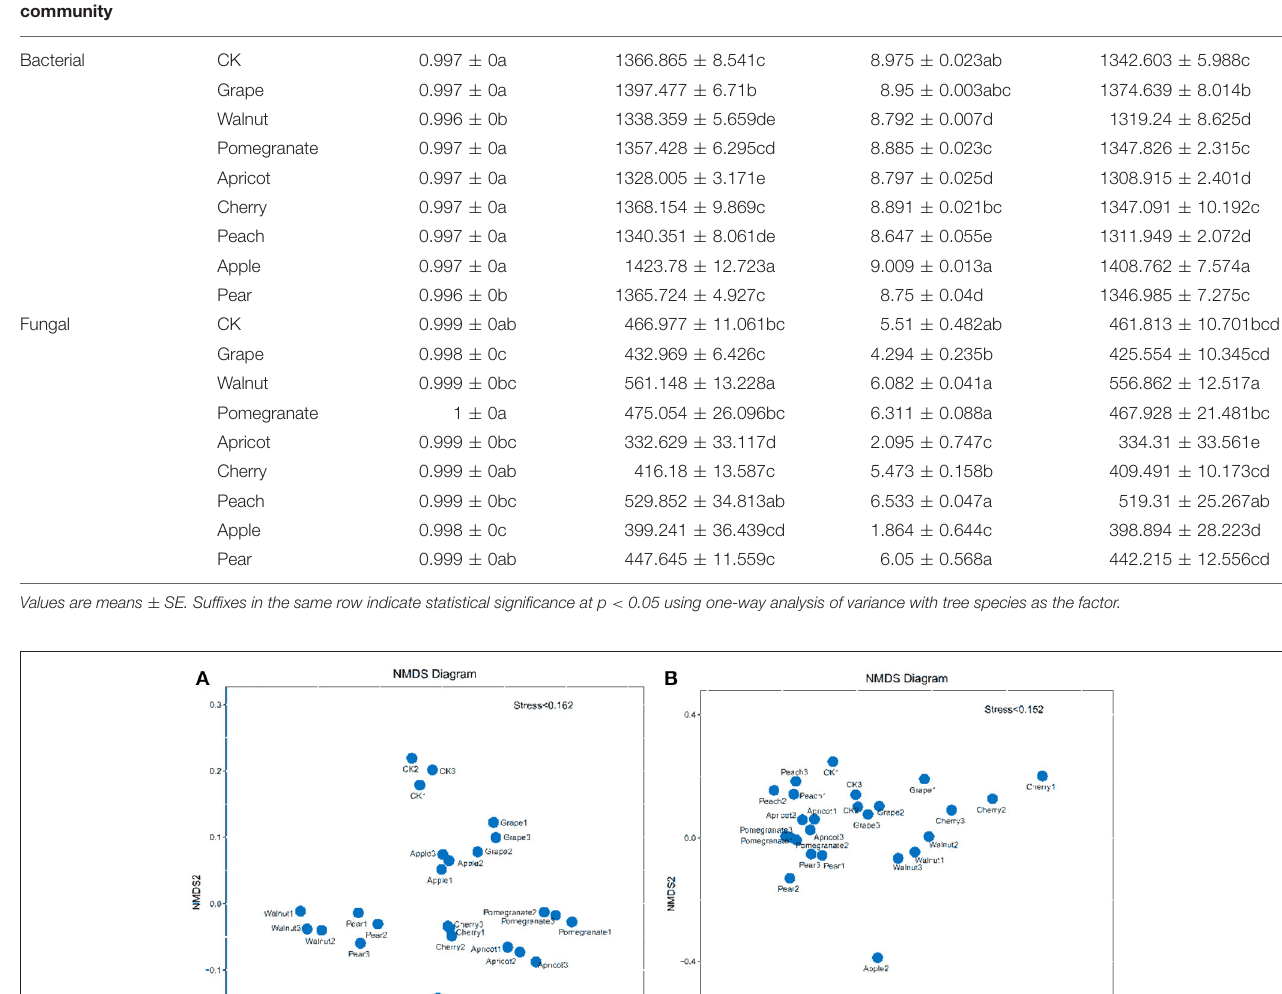
TABLE 3 | Bacterial and fungal a-diversity indexes of different deciduous fruit trees. Microbial Treats community